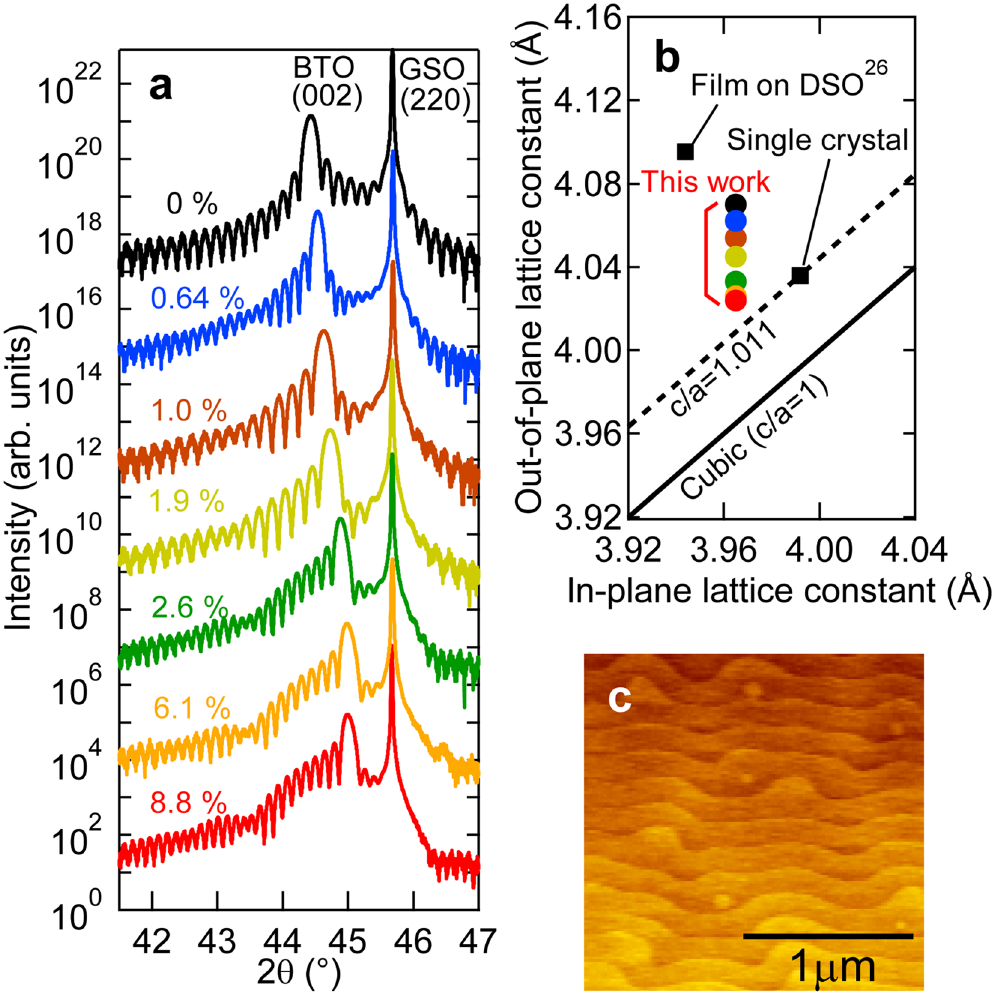
Figure 1. Crystal structure of La-doped BaTiO 3 films. ( a ) 2 θ − θ X-ray diffraction pattern of non-doped BTO and La-BTO films grown on GSO (110) substrates for the (002) peak of BTO and the (220) peak of GSO. ( b ) Lattice constants for non-doped BTO and La-BTO films, bulk single-crystalline BTO, BTO films on DSO and GSO substrates grown by MBE 26 . The solid line denotes the cubic structure ( c / a = 1) and the dotted line denotes the tetragonal structure ( c / a = 1.011) corresponding to single-crystalline BTO. ( c ) AFM image (2 × 2 μ m 2 ) of the surface of the BTO